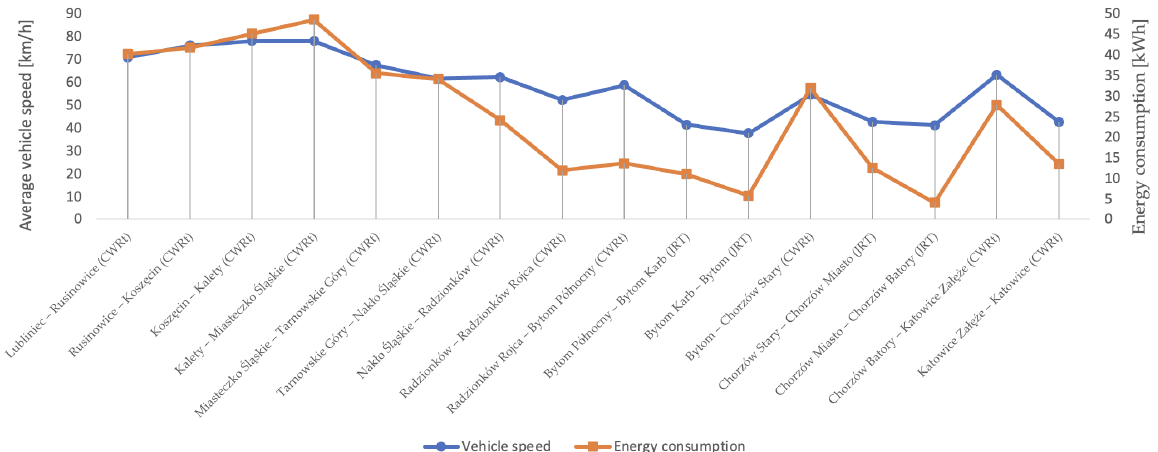
Figure 7. Correlation of traction electricity consumption in relation to average catenary-supplied electric vehicles speeds and travel distance along the complete route and the individual component of CWRt and JRT.